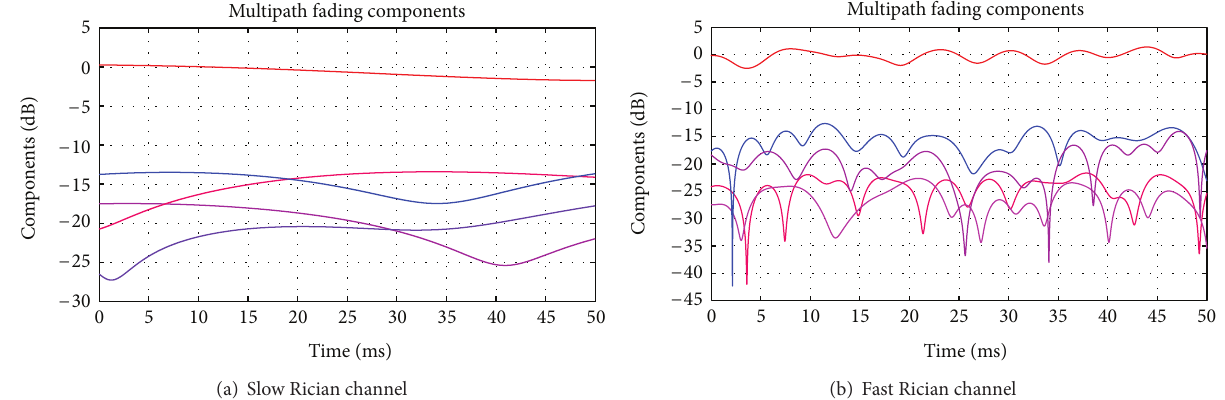
F 5: Variations of the Rician channel: change of the 5 paths in